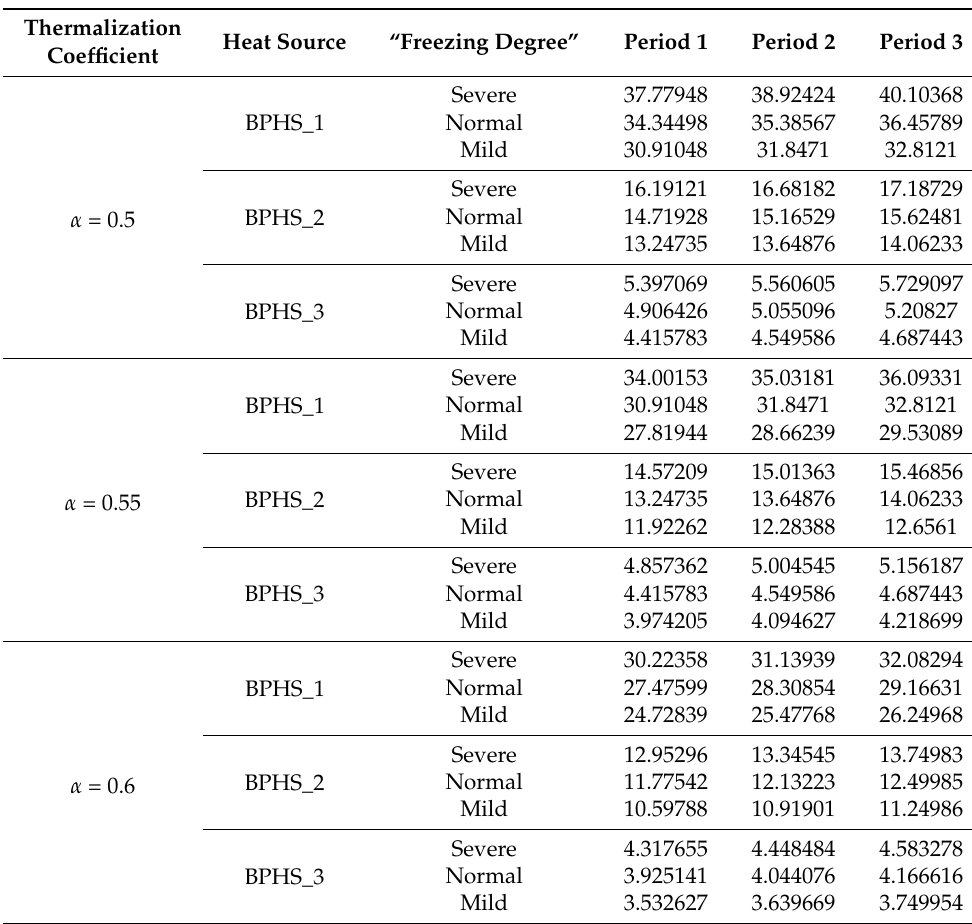
Table A5. Heating load undertaken by different peak-shaving heating sources,